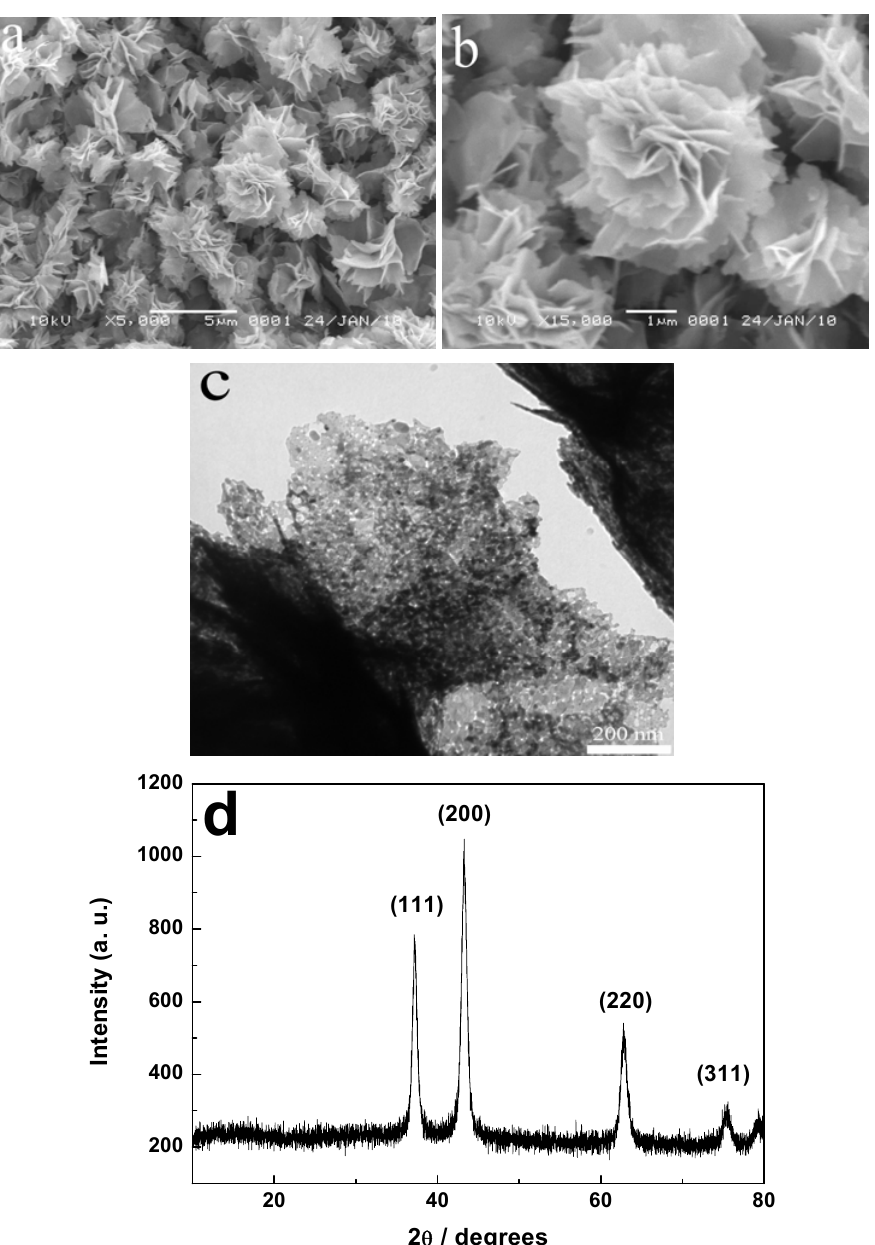
Figure 1. SEM images ( a , b ), TEM image ( c ), and XRD pattern ( d ) of the as-prepared